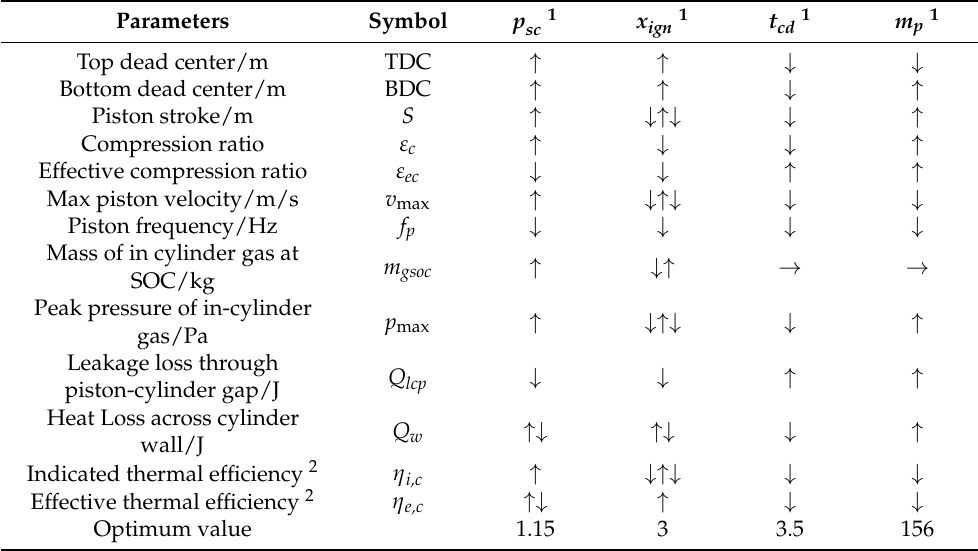
Table 2. Influences of parameters on the MFPG